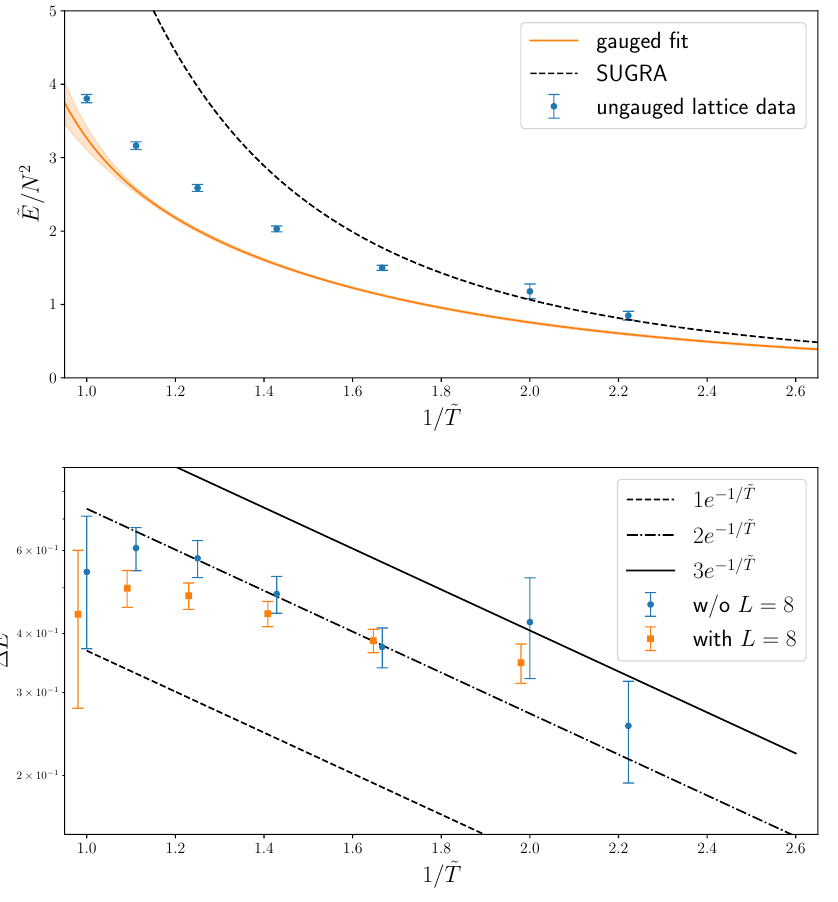
~ E 1 = 3 E Figure 4. [Upper] Large- N and continuum ~ E (cid:21) (cid:0) gauged (cid:17) gauged and ungauged (cid:17) ~ T 1 = 3 E 1 = 3 T . The former is a (cid:12)t to data in ref. [11], and it is (cid:21) (cid:21) (cid:0) (cid:0) ungauged as functions of (cid:17) compared with the leading order supergravity solution, shown as a dashed black line. [Lower] ~ E ~ E ~ T . Two sets of extrapolated ungauged en- Large- N and continuum (cid:1) ~ E ungauged (cid:0) gauged vs (cid:17) ergies are shown to assess systematic errors: one which includes L = 8 points in the continuum extrapolation and one that does not. At ~ T = 0 : 45, the ungauged simulations have not been per- formed at L = 8 because of numerical instabilities related to the (cid:13)at direction. We also show